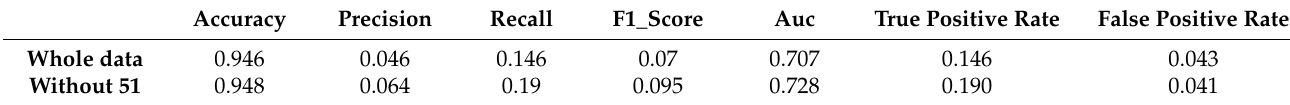
Table 5. Different measurement of the